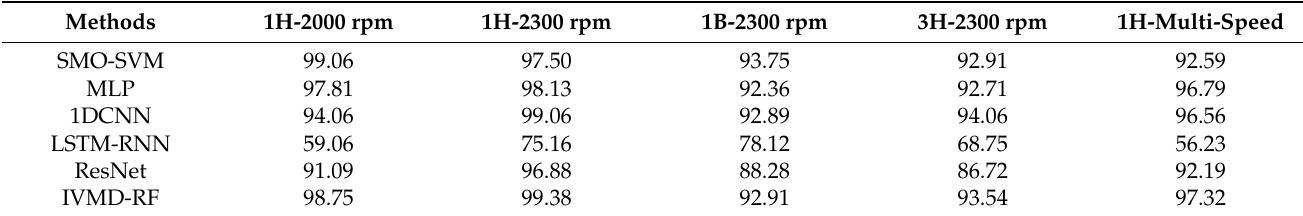
Figure 8. IVMD-RF fault detection process. Table 6. Accuracy comparison of different algorithms